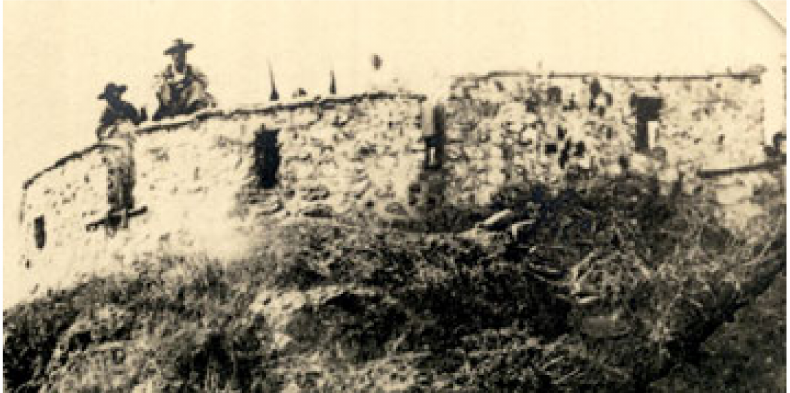
Figure 10. Materials(bakseok-stone) of Gapgot Dondae Fort. Ganghwado in 1876. Reprinted with permission from Ref. [46]. 1876, National Institute of Korean History.